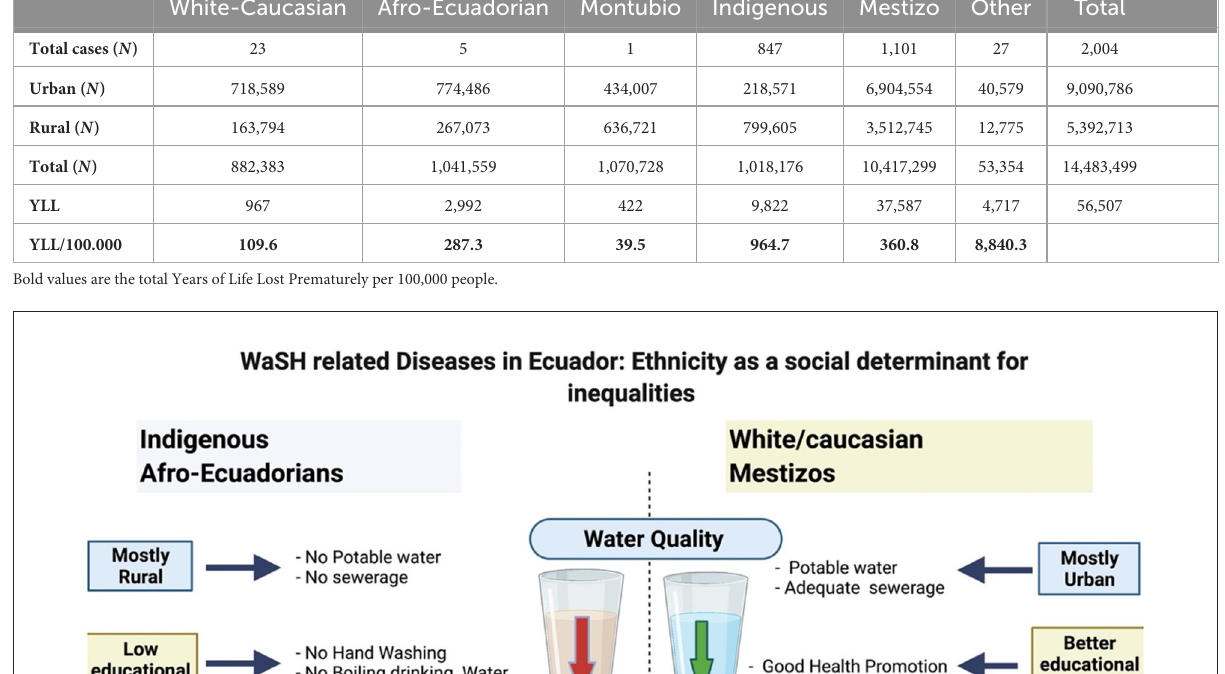
TABLE 7 Burden of WBD and years of life lost (YLL) prematurely caused by WBD in Ecuador from 2011 to 2020. White-Caucasian Afro-Ecuadorian Indigenous Mestizo